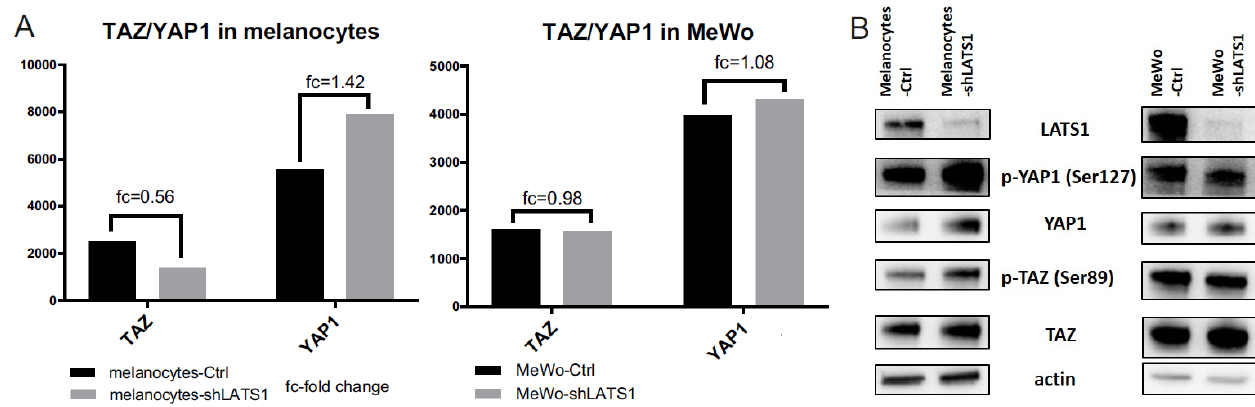
Figure 6. YAP1/TAZ expression in LATS1 knocked down cells. ( A ) Expression of YAP1 and TAZ genes in primary melanocytes (left) and MeWo cells (right); black bars—cells with regular LATS1 expression, grey bars—cells with LATS1 knocked down. ( B ) Western blotted lysates of control (Ctrl) and LATS1 knocked down (shLATS1) melanocytes (left panel) and MeWo (right panel).